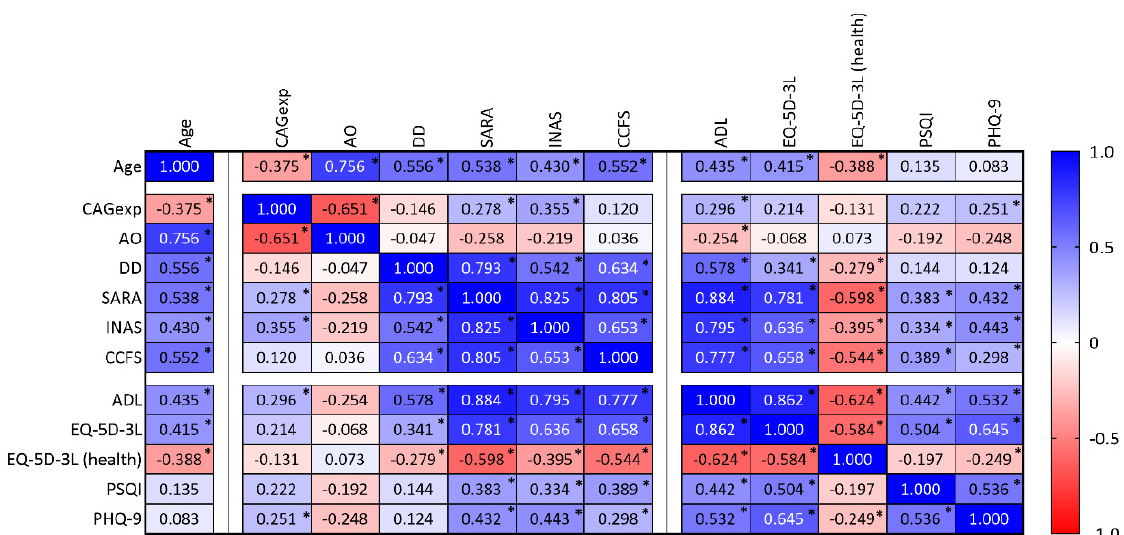
Figure 6. Correlation matrix showing variables analyzed in the present study, namely age, the number of CAG repeats in expanded alleles (CAGexp), age at onset (AO), disease duration (DD), SARA, INAS, CCFS, ASL, EQ-5D-3L (including the health status), PSQI, and PHQ-9. Spearman correlation coefficients (cell values) were shown, and each cell was colored according to its range and direction (positive or negative). * p -value lower than 0.05.